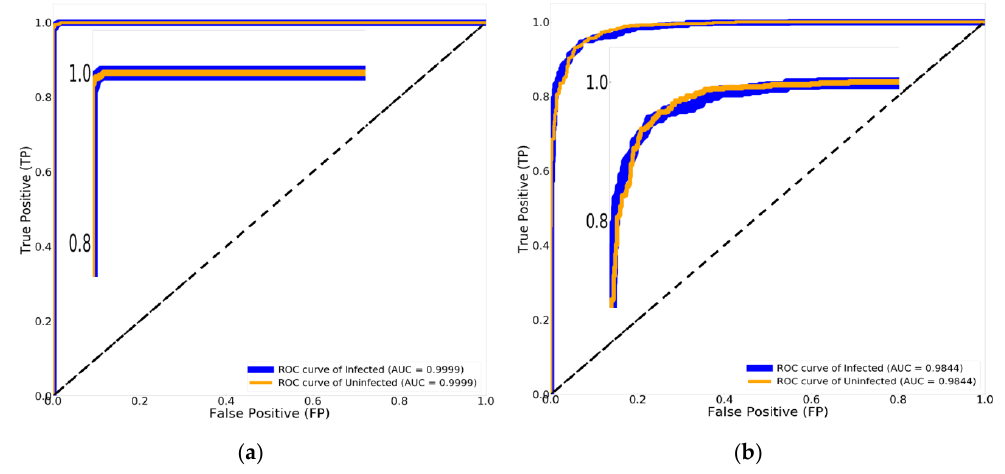
Figure 13. The results of Xception obtained by using the receiver operating characteristics (ROC) curve and area under the curve (AUC): ( a ) Xception combined with Nadam and Mish; ( b ) Xception (traditional method).